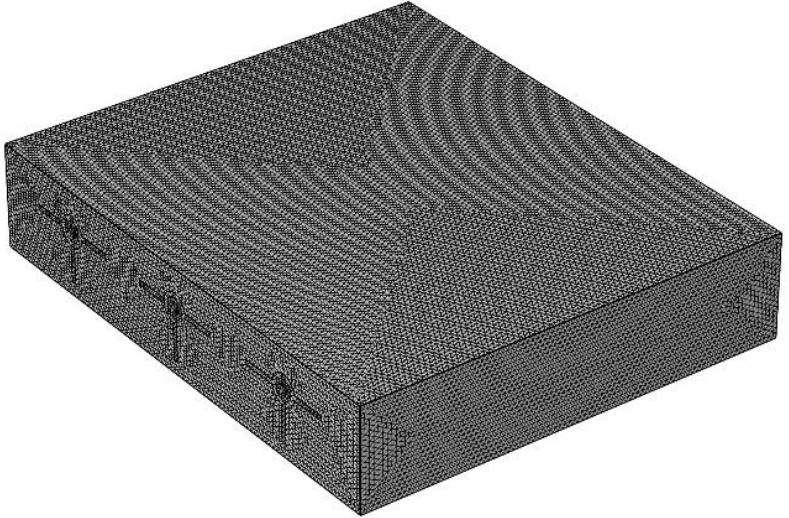
Figure 2. Meshed domain with hexagonal elements.